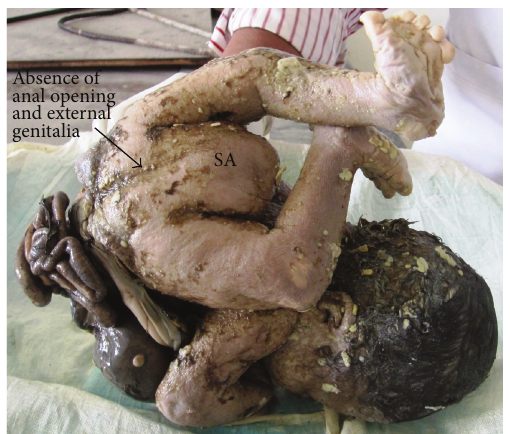
Figure 1: Showing sacrococcygeal mass (SA) and absence of anal opening and external genitalia.